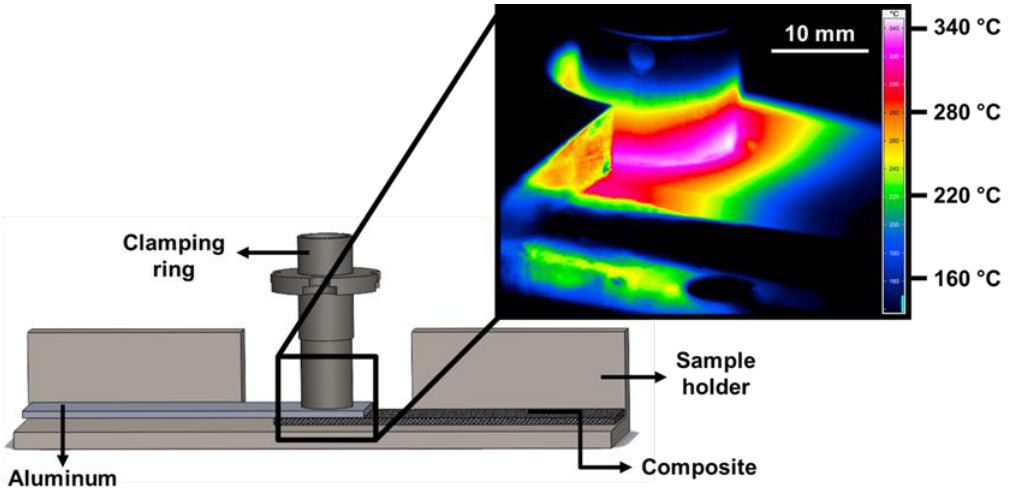
Figure 3. Schematic illustration of the set-up for infrared thermography and an example of the snapshot during the measurement.